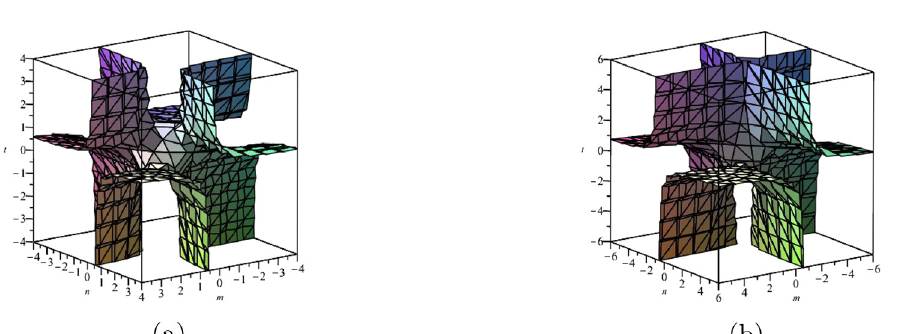
Figure 5: ( a ) The fi rst Zagreb β - index ( I ) and ( b ) the second Zagreb